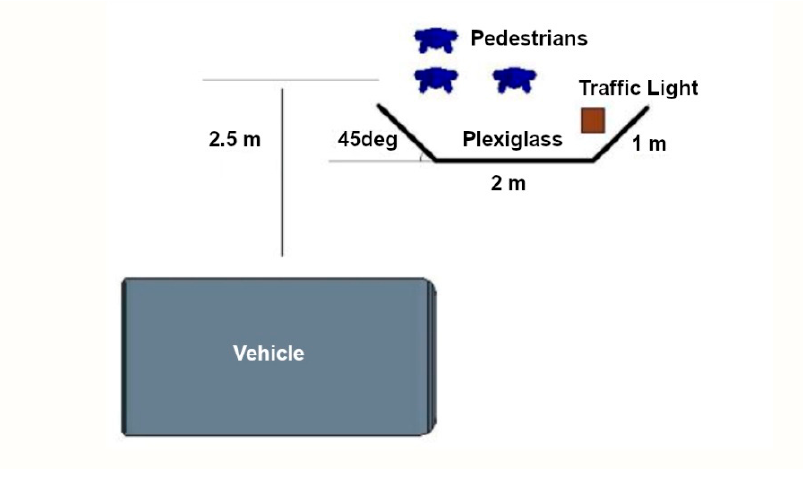
Figure 8. Schematic design of the plexiglass shield used by the traffic light (Top View).